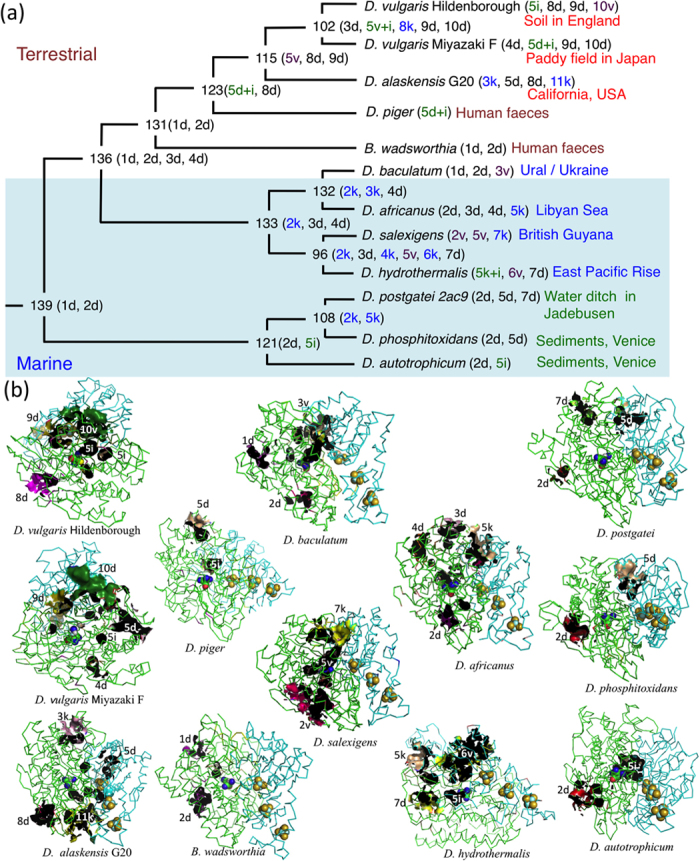
Molecular evolution of gas cavities in ancestral and extant [NiFeSe] Hases.(a) Diagram representation using cavity identity based on location and amino acid residues involved in the gas cavity and the designation of cavity size, dent (d) < crack (k) < crevice (v). The internal cavity (i) is an isolated cage near the Ni-Fe metal center. (b) Structures of modelled extant [NiFeSe] Hases including the MD models for D. vulgaris Hildenborough (2wpn.pdb)34 and D. baculatum (1cc1.pdb)35, which were also annealed on MD calculation. Gas cavities are designated as cavity identity and cavity size representation.